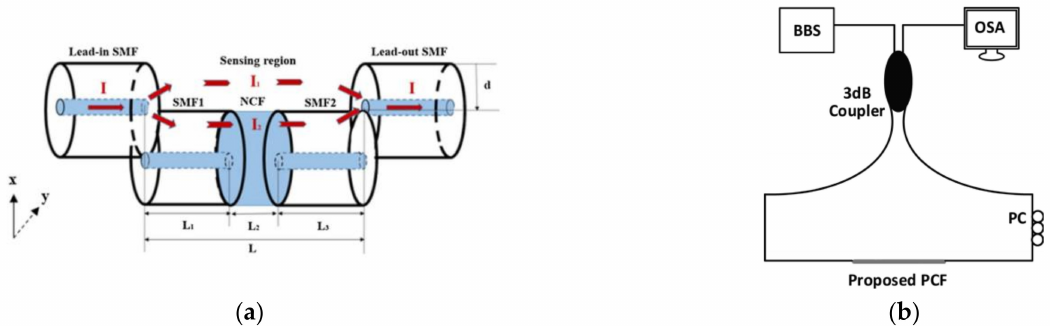
Figure 2. ( a ) Schematic diagram of an FPI based on offset splicing [68]; ( b ) SI generalized setup